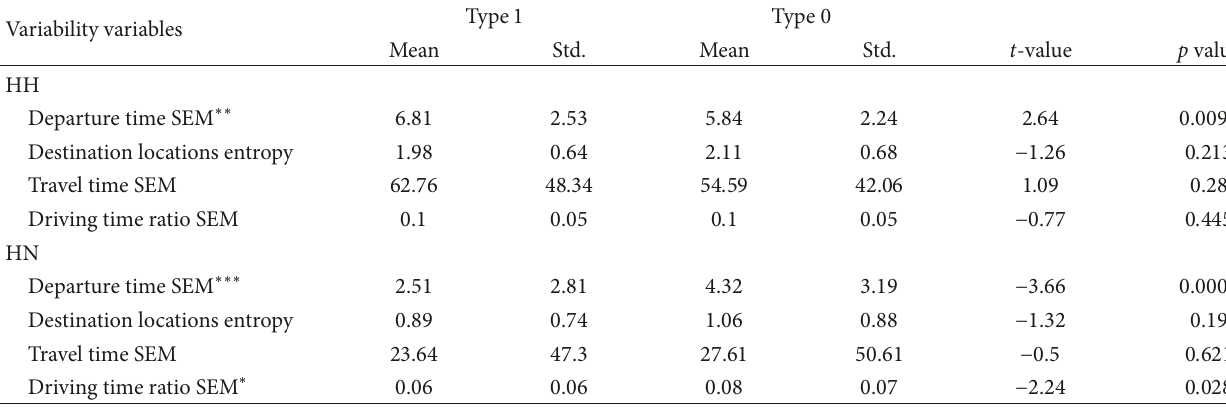
Table 2: Variability variables statistical details for binary class.